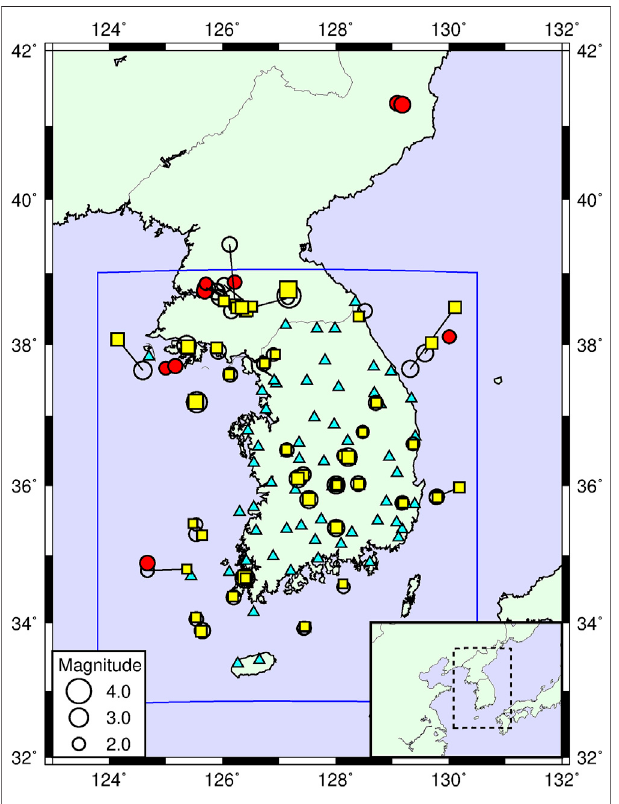
FIGURE 1 | Distribution of earthquakes and seismic stations (cyan triangles) used in this study. Circles represent earthquakes greater than or equal to magnitude 2.0, as reported by the Korea Meteorological Administration (KMA). Empty and red circles represent the events that were and were not associated by binder_max , respectively, while yellow squares indicate the epicenters of earthquakes associated by binder_max , which are linked with the epicenters located by the KMA. The blue solid line indicates the grid search area.